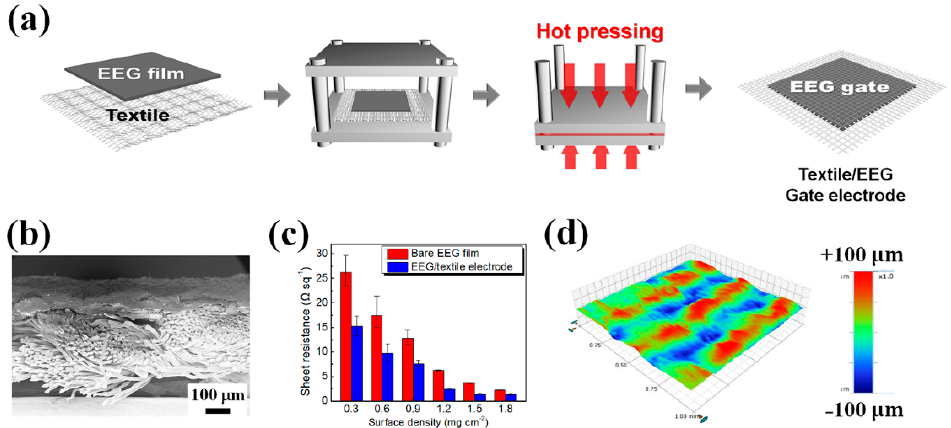
Figure 4. ( a ) Schematic illustration of the fabrication of EEG/textile gate electrode using hot pressing. ( b ) Cross-sectional SEM image of the EEG/textile gate electrode. ( c ) Changes in the sheet resistance of the bare EEG film and the EEG/textile gate electrode depending on the surface density of EEG films. ( d ) Surface 3D profile image of the EEG/textile gate electrode.